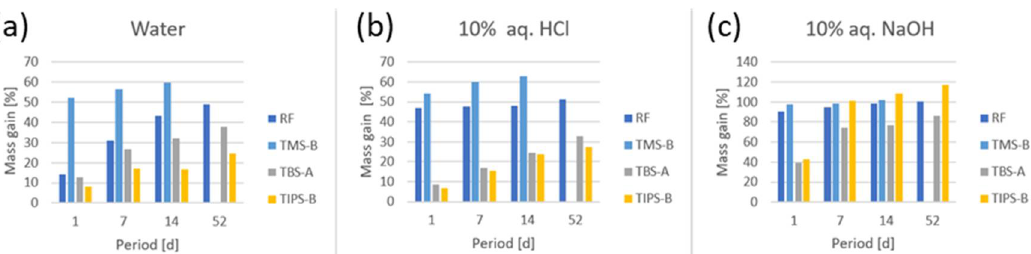
Figure 5. Uptake of liquid by monoliths exposed to ( a ) deionized water, ( b ) aqueous HCl solution, and ( c ) aqueous NaOH.